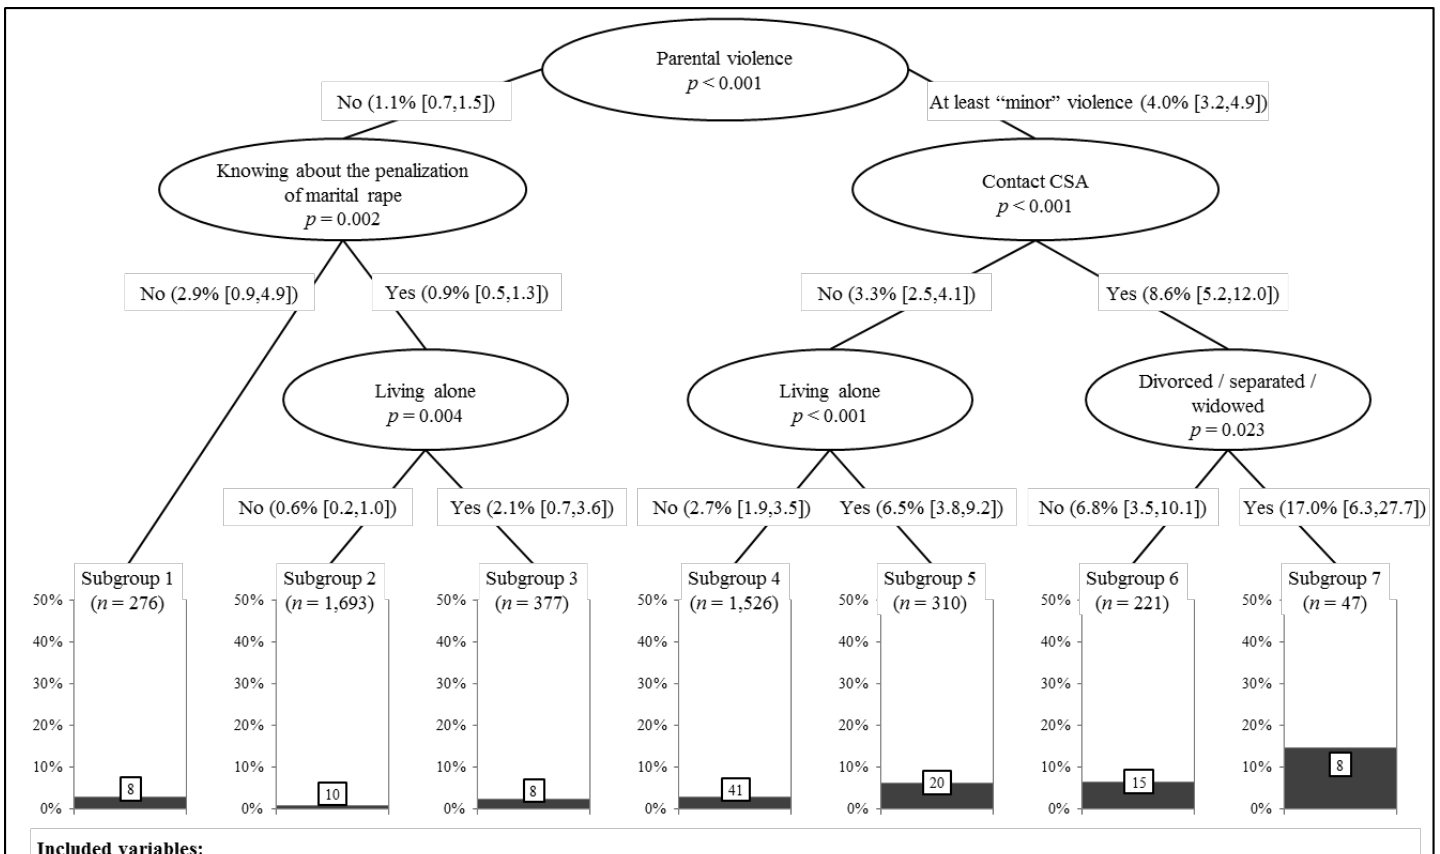
Figure 1. Conditional inference tree plot predicting five-year prevalence of sexual violence by age, educational degree, household size, origin, relationship status, residential area, contact CSA, parental violence, and knowledge about the penalization of marital rape ( N = 5450). Note : Paths are labeled with the probability of experiencing sexual violence in the respective step including 95% confidence intervals.